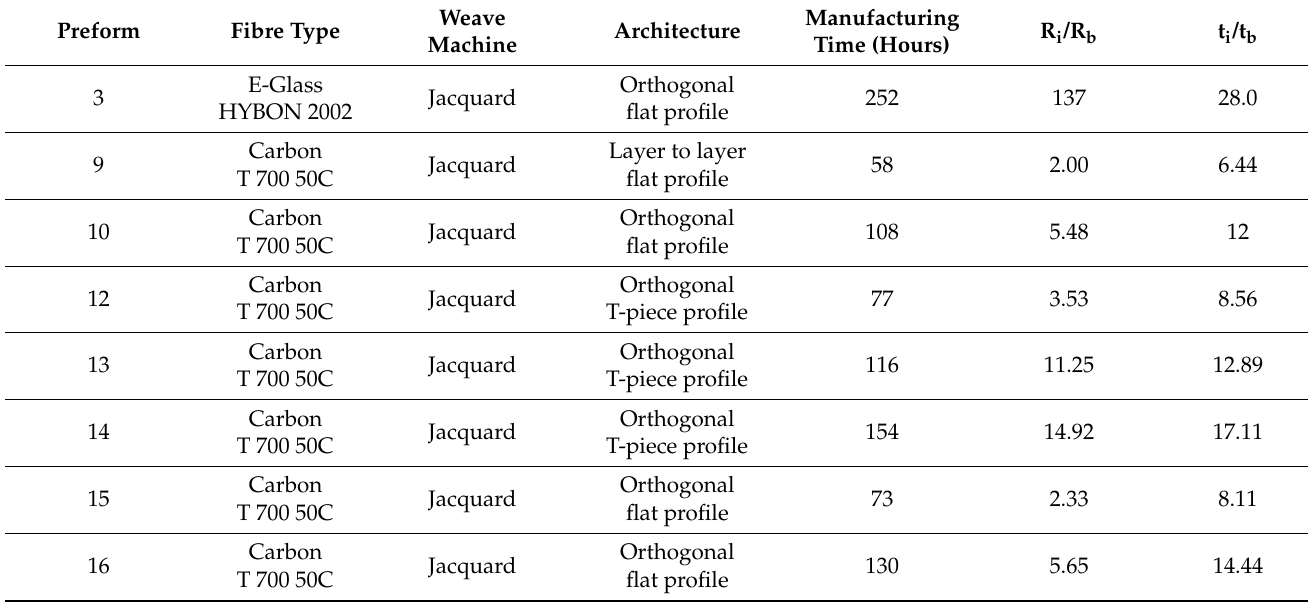
Table 2. Preforms woven on Jacquard loom.